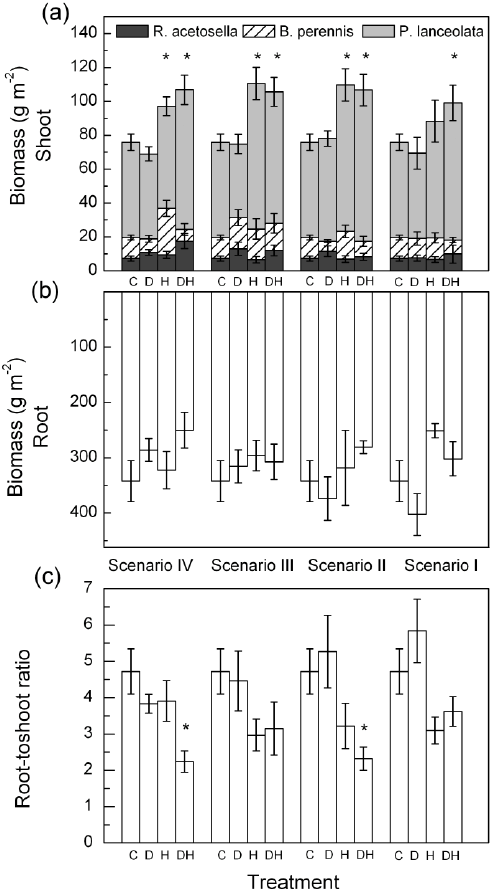
Fig. 6. Mean values and standard errors of the end-of-season (a) aboveground biomass, (b) belowground biomass and (c) root-to-shoot ratios, per scenario and treatment. C = control, D = drought, H = heat, DH = drought + heat. Asterisks indicate significant differences between treatment and control on the community level ( P < 0.05). For differences on the species level, please refer to the text. Scenario IV = 42 days interval between subsequent events, scenario III = 25 days interval, scenario II = 14 days interval, scenario I = single event.